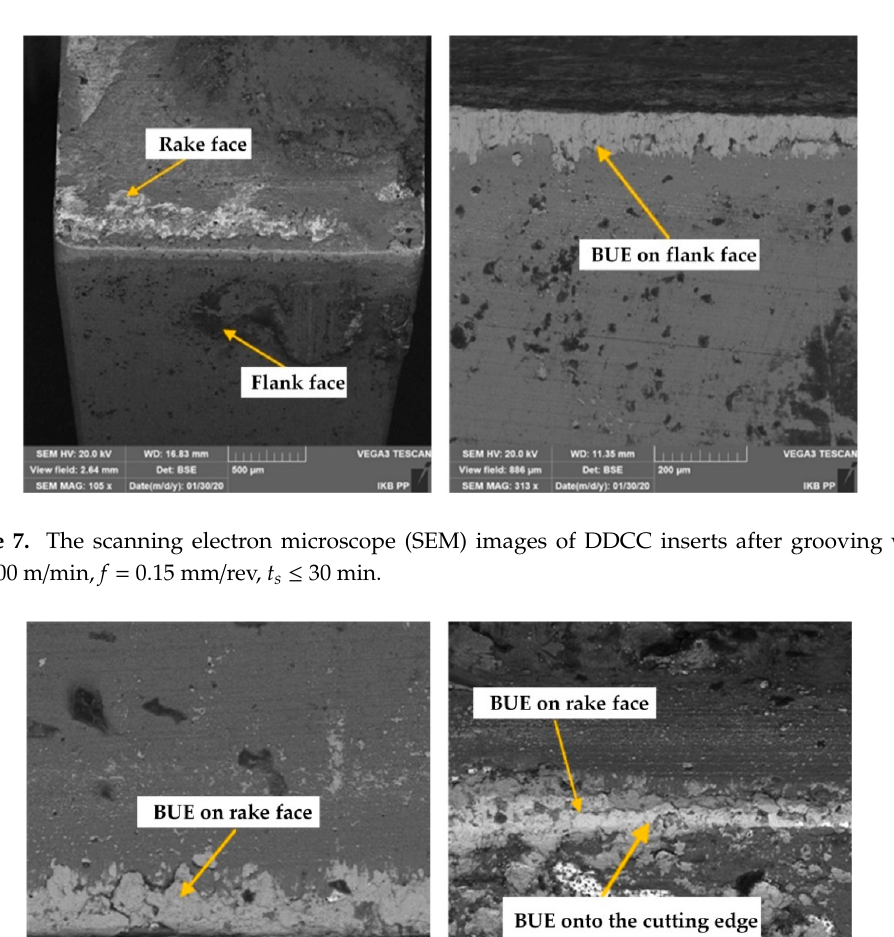
Figure 9. The SEM images of DDCC inserts after grooving with v c = 1200 m/min, f = 0.2 mm/rev, t s ≤ 8 min.